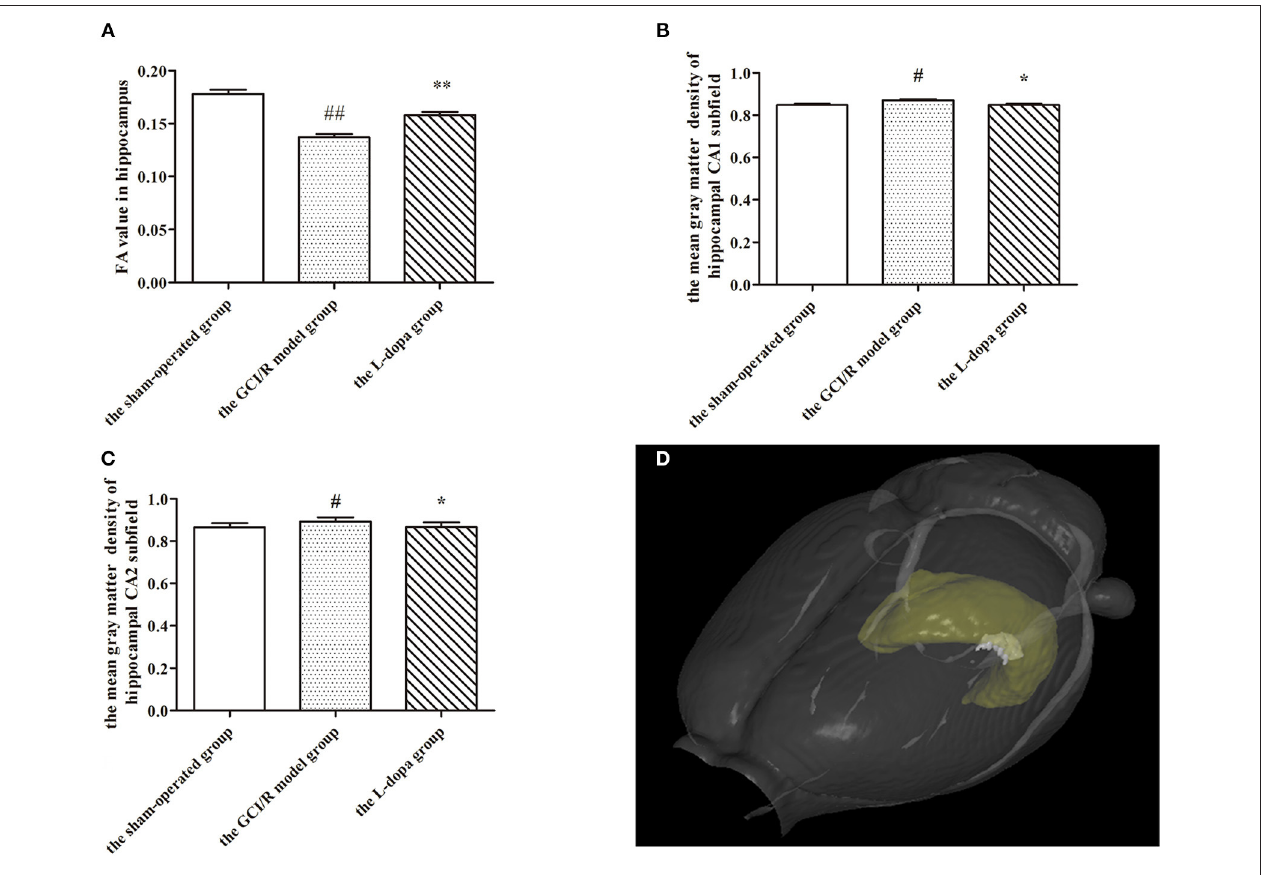
FIGURE 2 | MRI imaging data. (A) Comparison FA value in hippocampus among groups. The mean gray matter density of hippocampal CA1 (B) and CA2 (C) subfield. (D) A three-dimensional (3D) rendering of regions with significant differences in gray matter density among groups. Data are shown as means ± SD. ## p < 0.01 vs. the sham-operated group, ** p < 0.01 vs. the GCI/R model group. # p < 0.05 vs. the sham-operated group, * p < 0.05 vs. the GCI/R model